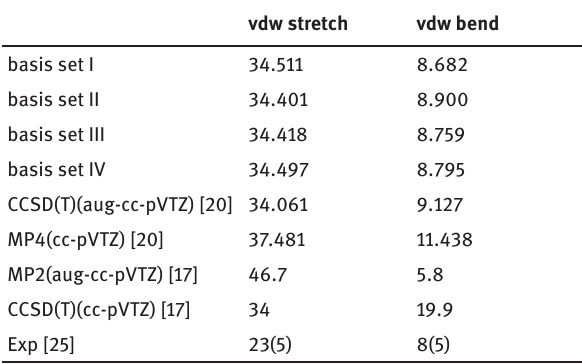
Table 4: The intermolecular vibrational frenquency (in cm -1 ) of the C Ar